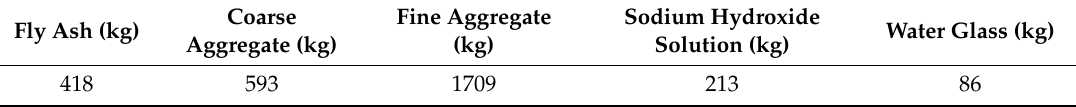
Figure 2. Fibers. ( a ) hooked end steel fiber and ( b ) polypropylene fiber. Table 1. Mix proportion of geopolymer concrete.